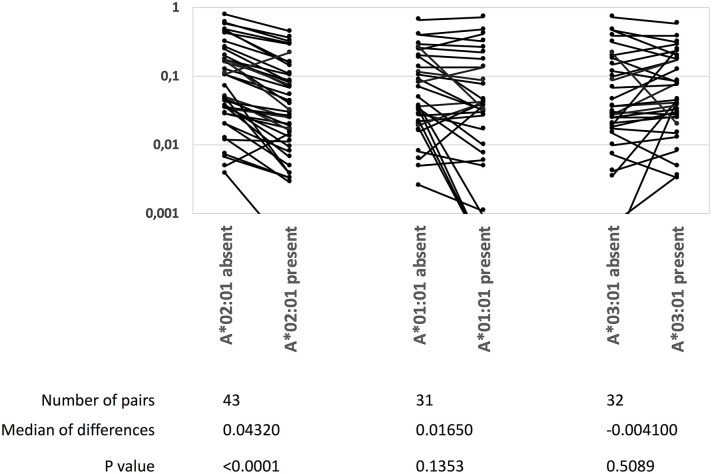
A highly immunodominant CD8+ T cell response correlates with a reduction of other CD8+ T cell responses. The NS4B214−222-specific, HLA-A*02:01-restricted CD8+ T cell response is highly immunodominant. The presence or absence of HLA-A*02:01, HLA-A*01:01 or HLA-A*03:01 in 142 donors were correlated with the magnitudes (measured as % TMR+, CD8+ T cells) of up to 45 YFV-specific, HLA-B-restricted CD8+ T cell responses. The data was analyzed by Wilcoxons matched-pair signed rank test (GraphPad Prism 8).